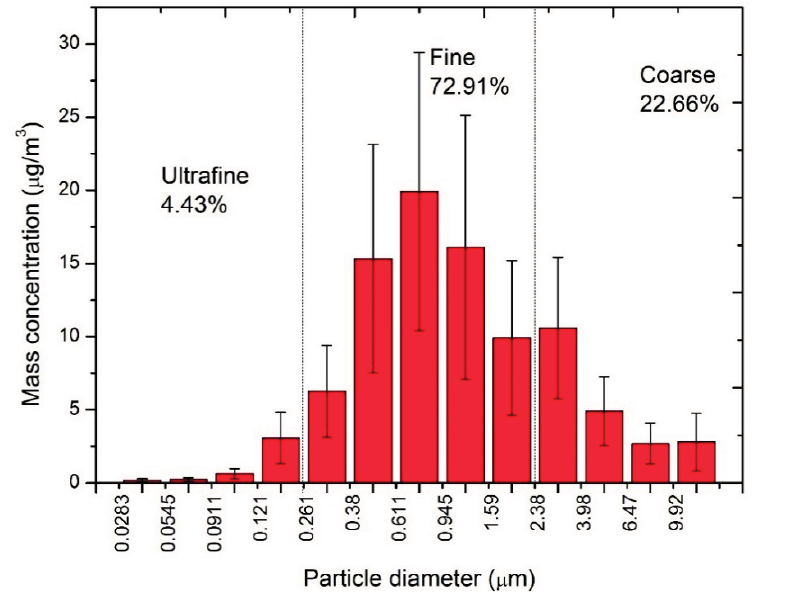
Figure 2. Average mass concentrations ( μ g/m 3 ) of the 13-size particles of PM samples around